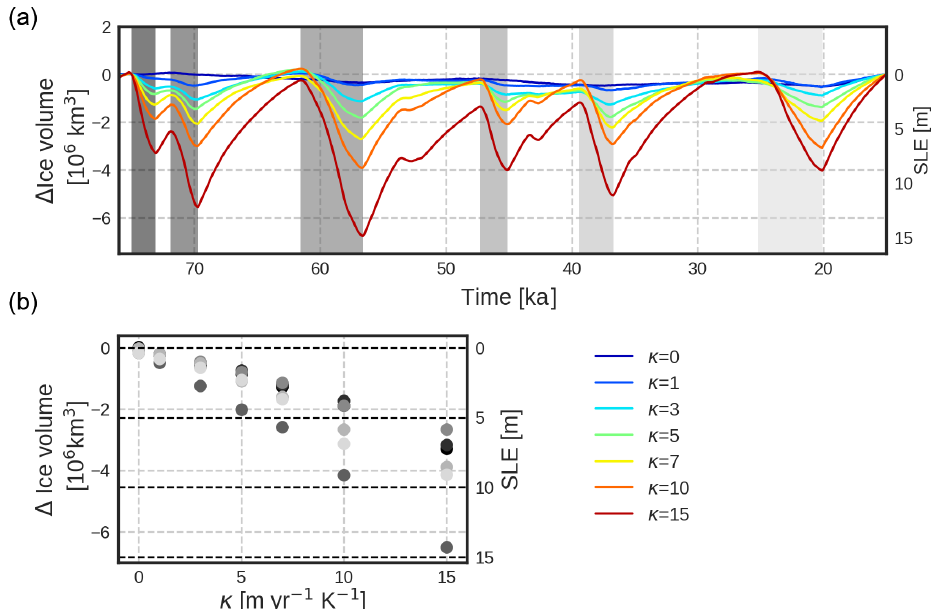
Figure 7. (a) Simulated ice volume anomaly between 75 and 15ka for different values of oceanic sensitivities. Anomalies are calculated relative to the state at 15ka and detrended between 75 and 15ka. Grey illustrates significant ice discharging events with increasingly darker grey colors for older events. (b) Scatterplot of the sea-level contribution of every discharging phase with respect to κ .